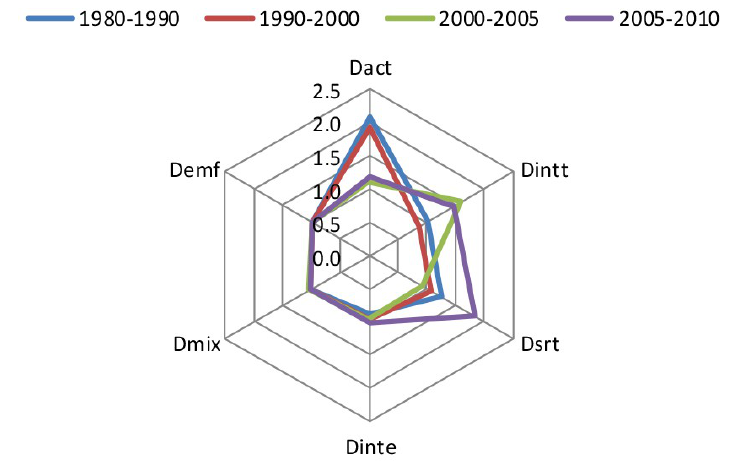
Figure 8. Radar chart for CO 2 emission decomposition in multi-stages